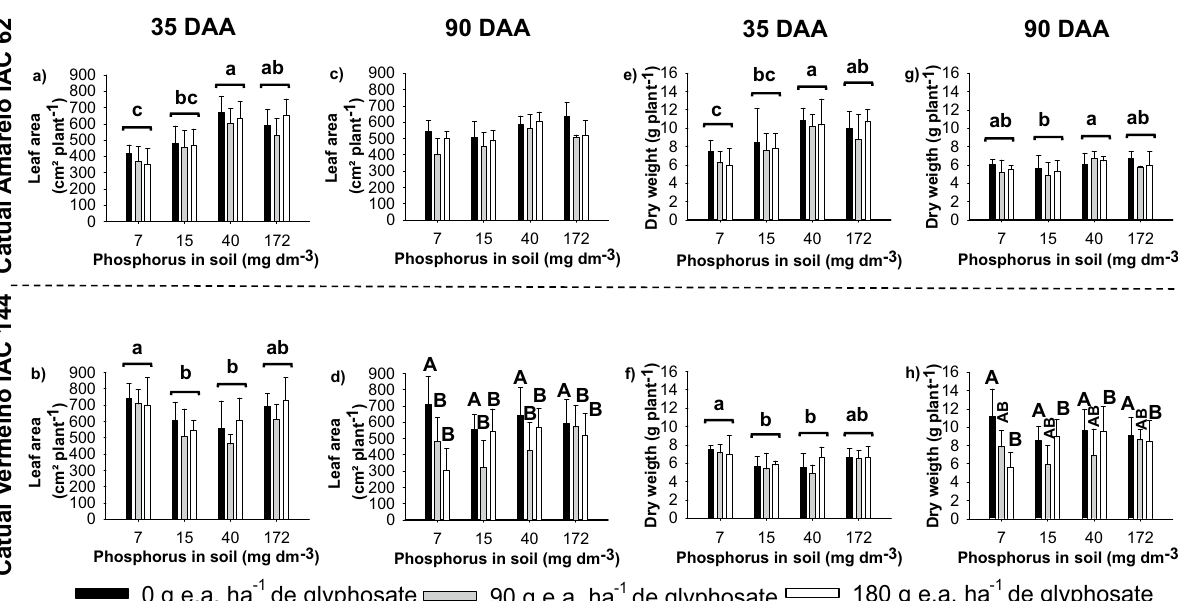
Figure 2. Leaf area and dry matter of Arabica coffee cultivars Catuaí-Amarelo/IAC-62 ( a , c , e , g ) and Catuaí- Vermelho/IAC-144 ( b , d , f , h ), cultivated in soils with different levels of P and subjected to subdoses of glyphosate at 35 and 90 days after application (DAA). For each variable and evaluation time, same lower-case does not differ between the soil P contents, and same upper-case do not differ between the subdoses of glyphosate by the Tukey test at 5% probability. Vertical bars indicate the standard deviation ( n = 4). Plots were drawn using SigmaPlot ver. 10.0 (Systat Software, Inc., San Jose, USA, www. systa tsoft ware.